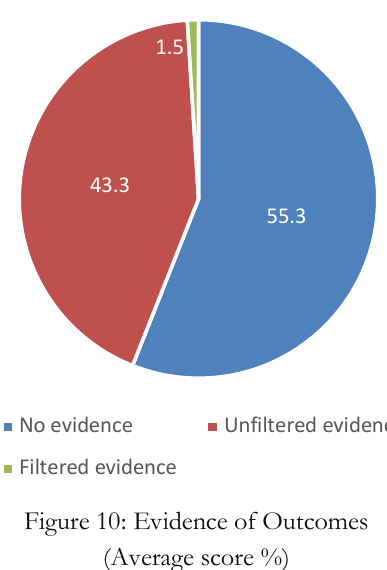
Figure 10: Evidence of Outcomes (Average score